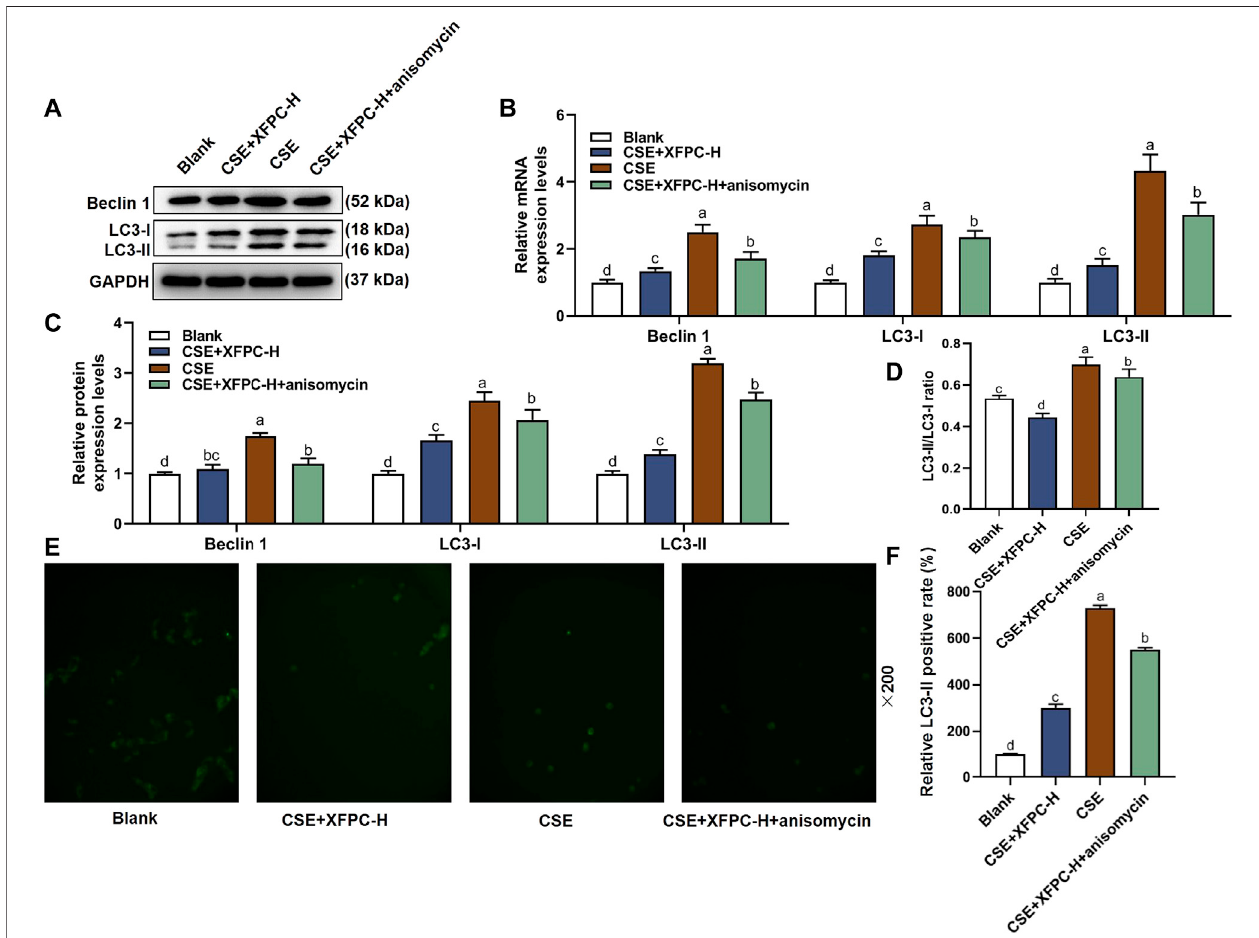
FIGURE 5 | XPFC reduces CSE-induced autophagy in HBE cells by inhibiting JNK pathway. (A) Effect of XFPC-H and p38 activator anisomycin on protein expression ofautophagyindicatorproteinsBeclin1,LC3-Iand LC3-II wereanalyzedbywesternblot. (B) Quanti fi cationofthemRNAexpression levelsofBeclin1,LC3-I and LC3-II. (C) Quanti fi cation of protein levels of Beclin 1, LC3-I and LC3-II from western blot of panel (A) . (D) The relative protein expression level of LC3-II compared withLC3-Ifromwesternblotofpanel (A) . (E) FormationofLC3-IIpunctainHBEcellswasanalyzedbyimmuno fl uorescenceunder fl uorescencemicroscopy( × 200). (F) TherelativeLC3-IIpositiverateindicatinglevel ofautophagy wasshown.Lowercase lettersindicatestatisticallysigni fi cantdifferences ( p < 0.05)accordingtoANOVA followed by Tukey ’ s HSD test. XFPC, Xuanfei Pingchuan Capsules; CSE, cigarette smoke extract; HBE cells, human bronchial epithelial cells; LC3, microtubule- associated protein light chain three; p-p38,